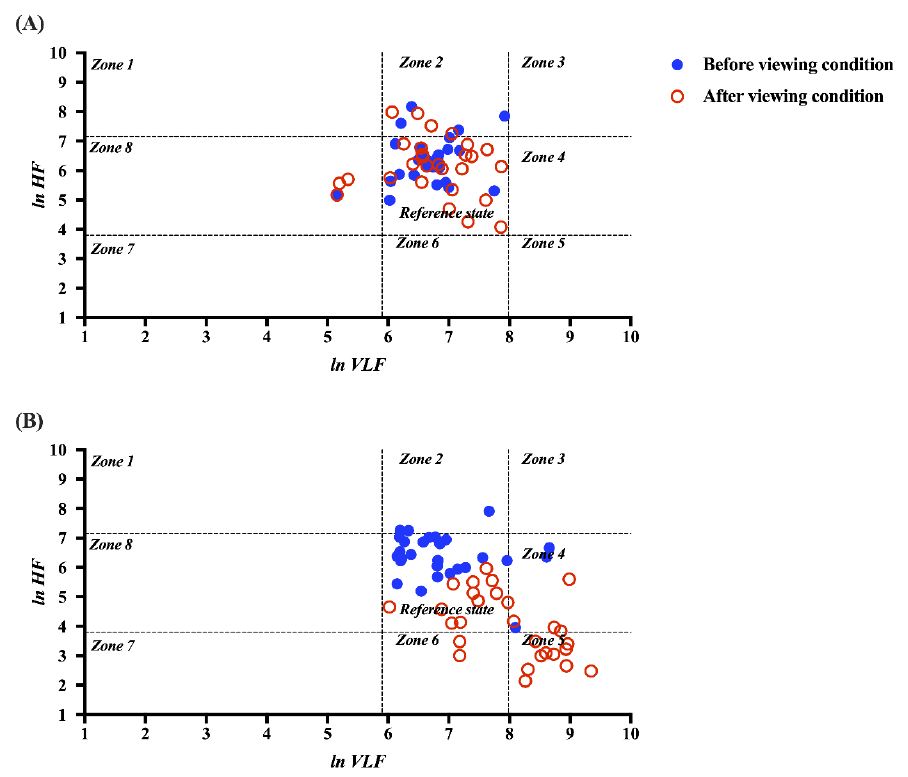
Figure 5. Comparison of the autonomic balance (normalized HRV) before and after the ( A ) 2D and ( B ) VR viewing conditions, structured by predefined zones of distribution.